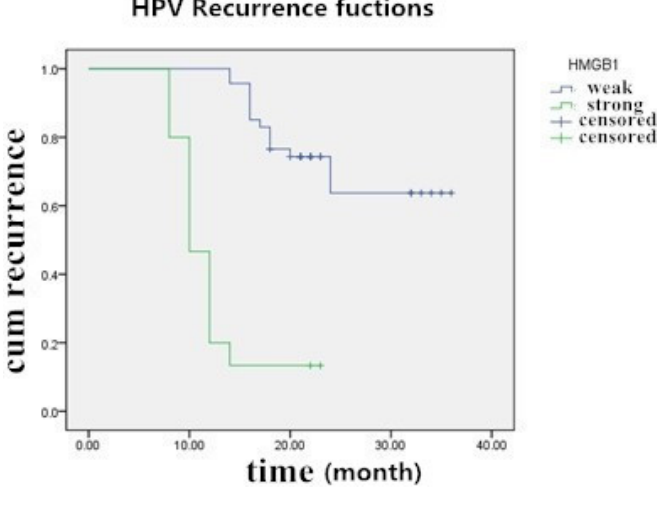
Figure 5. Kaplan-Meier survival curve of 62 patients with cervical cancer and CIN III according to HMGB1 protein staining.